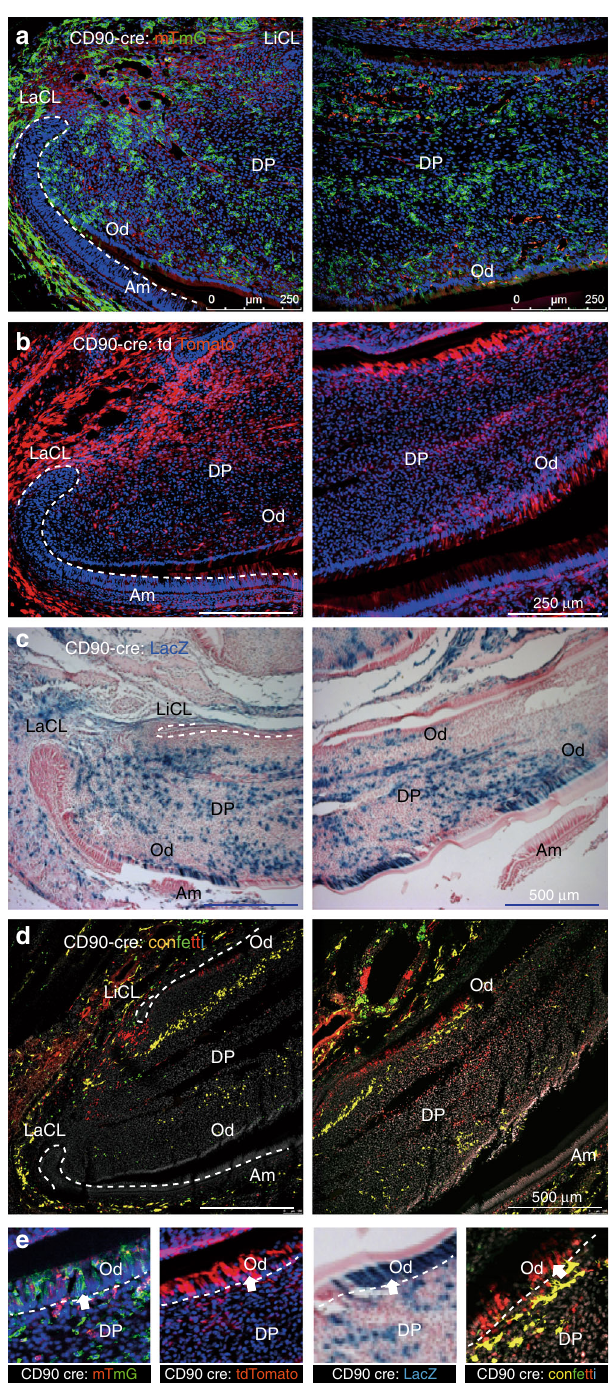
Fig. 2 Lineage tracing of CD90/Thy1 in the postnatal mouse incisor. CD90/ Thy1 cre mouse line crossed with different reporter lines, a Rosa26R; -mTmG, b Rosa26R-tdTomato, c Rosa26R;-LacZ, and d Rosa26R;-Confetti, shows CD90/Thy1 expressing cells and their progeny contribute to pulp cells and odontoblasts. d Confetti predominately labels single cell clones; thus each single color represents the progeny from one stem cell. e Enlarged region from each reporter line showing CD90/Thy1-derived odontoblasts. PN5-10 postnatal incisor samples were used in a – c , PN21 mouse incisors were used in d . N > = 5 pups each